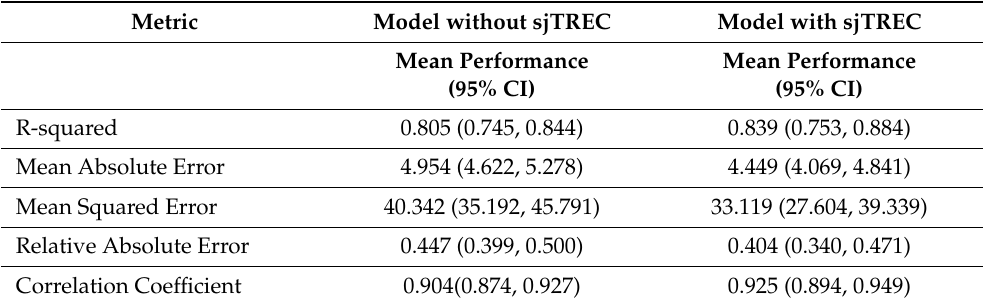
Table 3. Prediction accuracies of the SVR models obtained in JADBIO using the average methylation value of the ELOVL2 promoter region alone or in combination with sjTREC content.